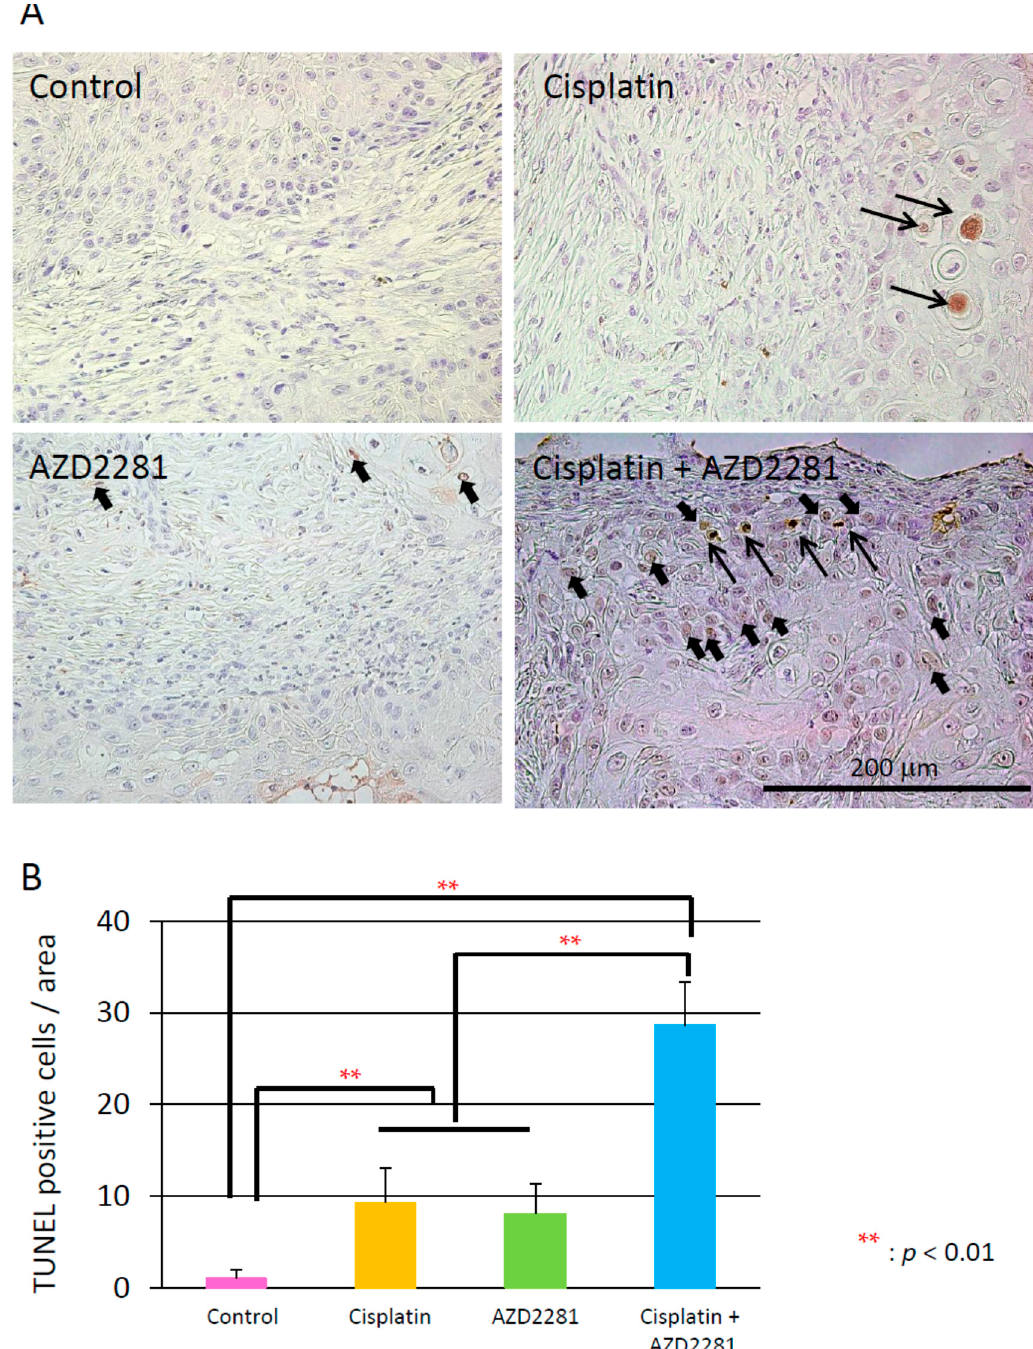
Figure 5. ( A ) TUNEL staining of xenografted tumors in control ( upper left ); cisplatin ( upper right ); AZD2281 ( lower left ); and combination ( lower right ) groups. Open arrows indicate apoptotic cells, and closed arrows indicate pre-apoptotic cells. Scale bar, 200 µm; ( B ) TUNEL-positive cells (both apoptotic and pre-apoptotic cells) per area in each treatment group. ** p < 0.01.